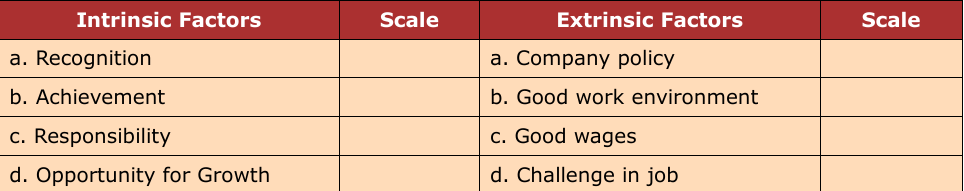
Table 1. Intrinsic and Extrinsic Factors of